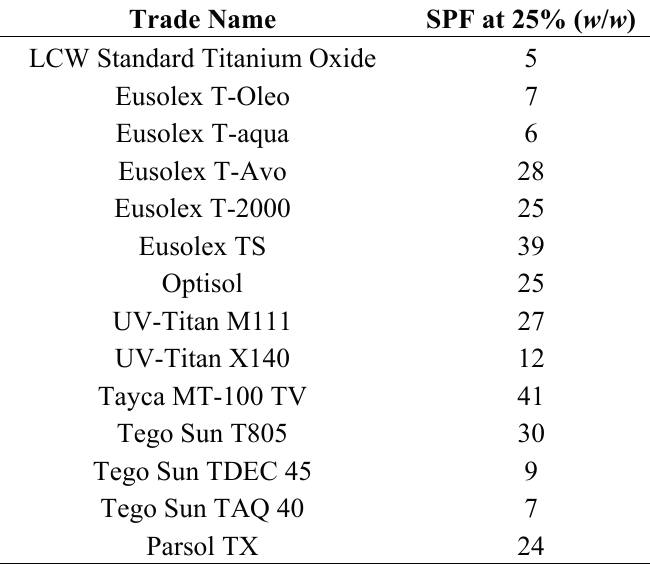
Table 4. Efficacy of different commercial forms of titanium dioxide compared in terms of photoprotection